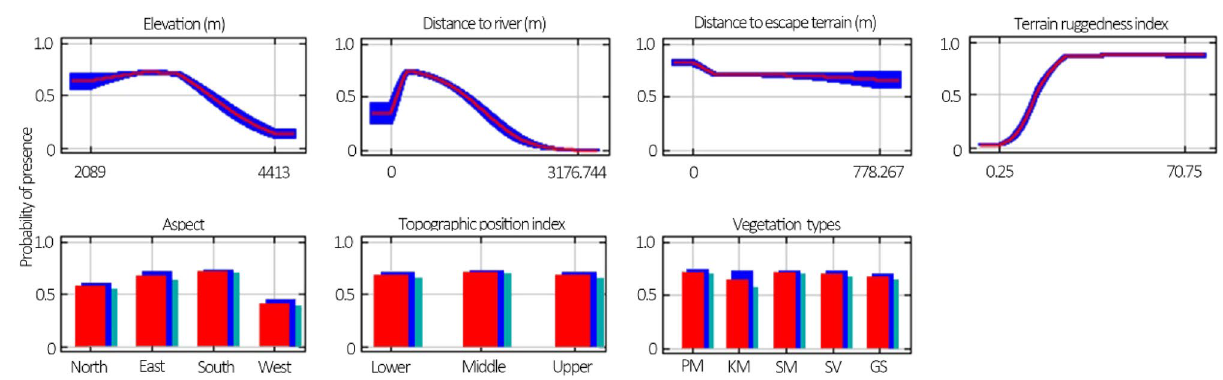
Figure 2. Response curves for the seven variables of females. The curves show the mean response of the 10 replicate Maxent runs (red) and the mean ± one standard deviation (blue, two shades for categorical